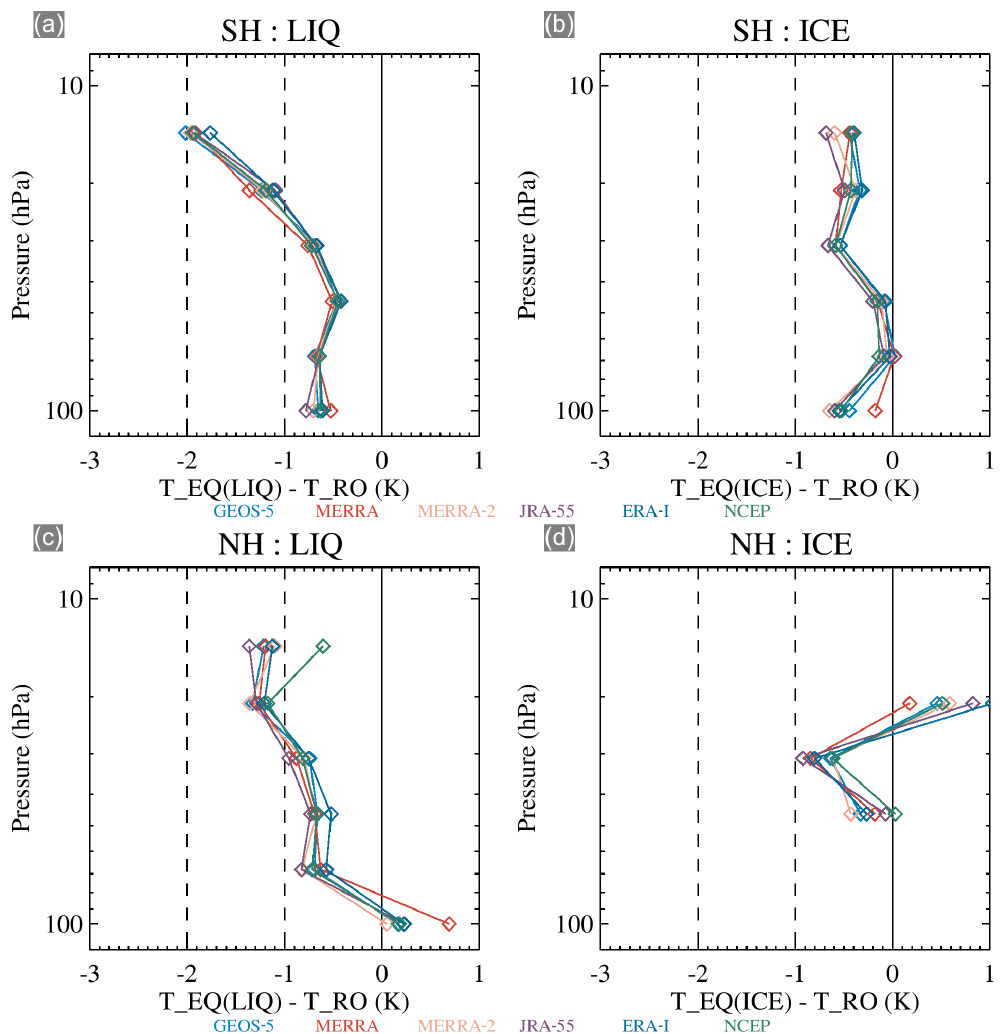
Figure 19. Vertical profiles of the temperature differences between (a) LIQ equilibrium and COSMIC GPS RO, (cid:49)T LIQ − (cid:49)T COSMIC , and (b) ICE equilibrium and COSMIC RO, (cid:49)T ICE − (cid:49)T COSMIC , for the Antarctic. (c, d) The same as for panels (a, b) except for the Arctic. Lines for the different reanalyses are color coded according to the